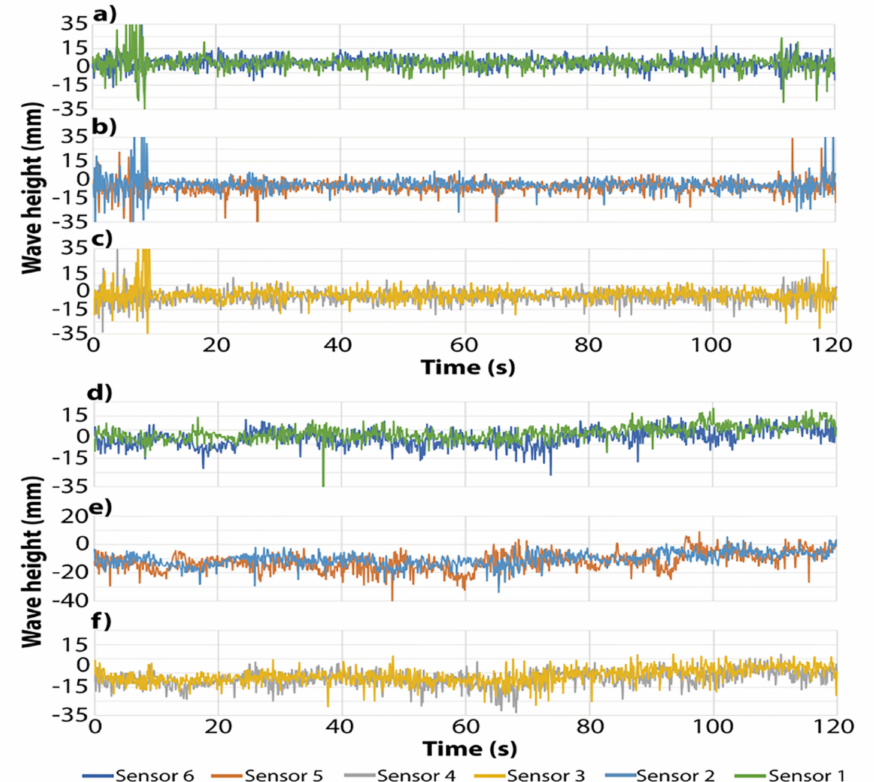
Figure 19. Variations in meniscus level using nozzles with clogging. ( a ) Sensors 1 and 6 with nozzle A. ( b ) Sensors 2 and 5 with nozzle A. ( c ) Sensors 3 and 4 with nozzle A. ( d ) Sensors 1 and 6 with nozzle B. ( e ) Sensors 2 and 5 with nozzle B. ( f ) Sensors 3 and 4 with nozzle B.